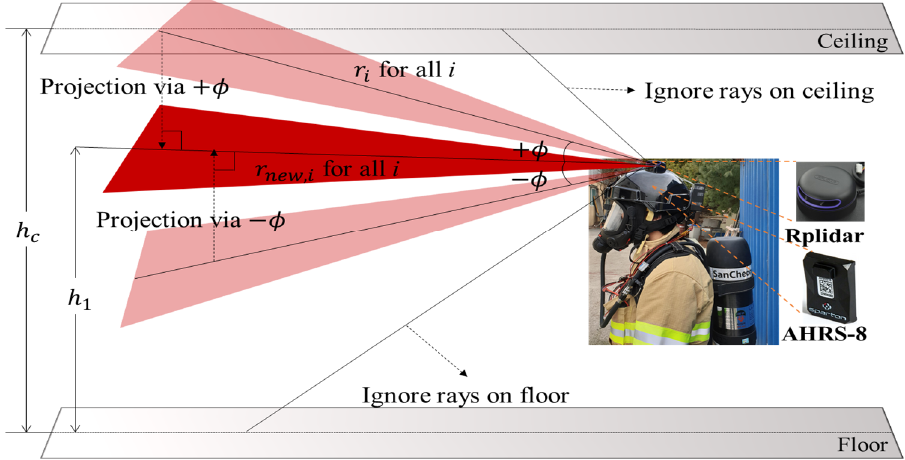
Figure 4. Smart helmet with RPlidar A3 and attitude heading and reference system (AHRS-8), and a projection at the rescuer’s height.